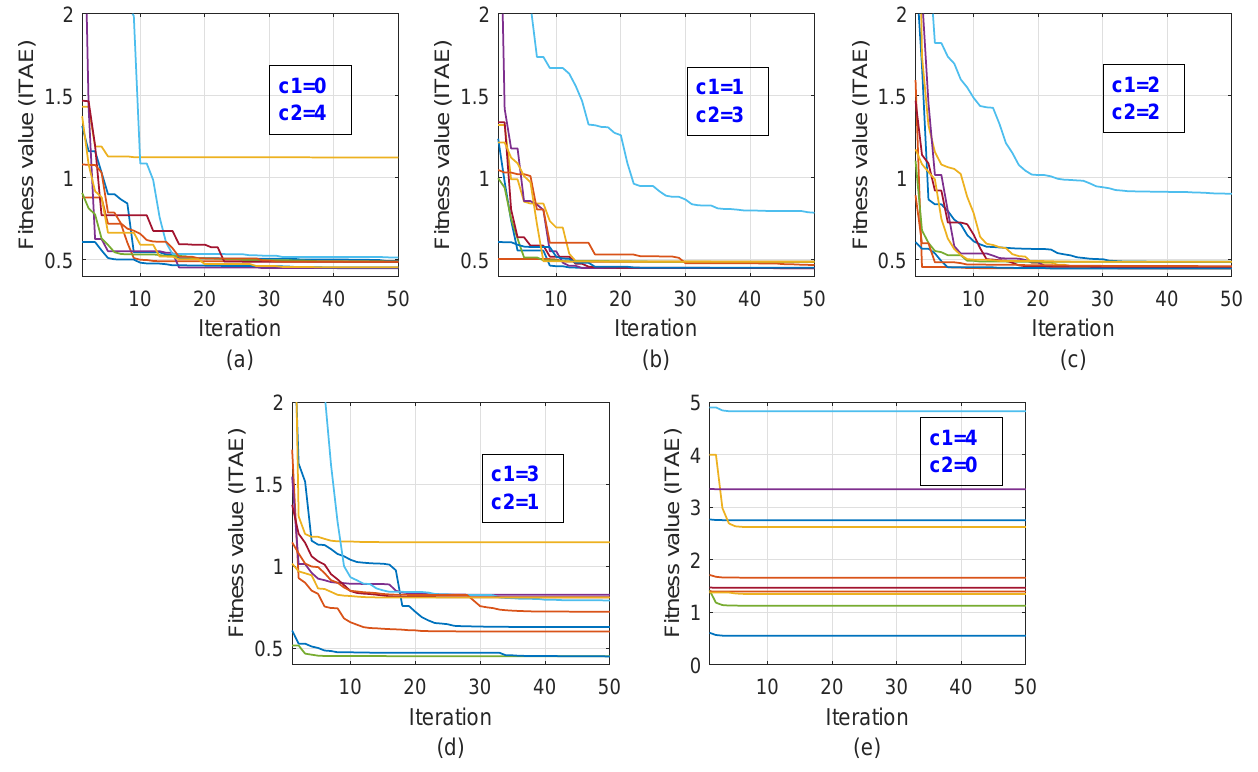
Figure 5. Fitness values obtained with different acceleration parameters for 10 different trial: (a) c1=0, c2=4; (b) c1=1, c2=3; (c) c1=2, c2=2; (d) c1=3, c2=1; (e) c1=4, c2=0.